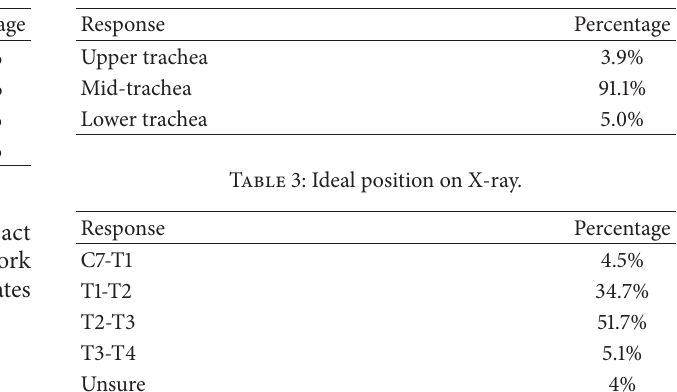
Table 1: Representation of respondent. Table 2: Ideal position of the ETT.